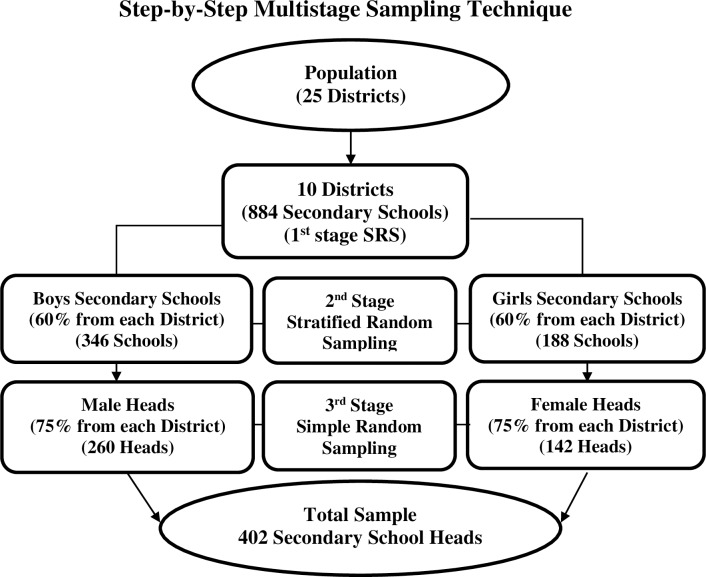
Multistage sampling technique.